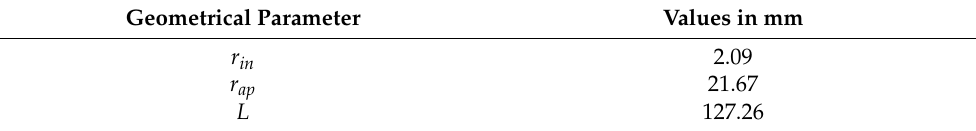
Figure 12. Photographs of the ( a ) simulated design of V-band horn having 3 node points (th m = 3 mm, λ c = 5.45 mm); fabricated V-band horn antennas with 2 and 3 node points ( b ) lateral view ( c ) front view. Table 4. Geometrical parameters of the scaled-down model (scaling factor = 2.545).